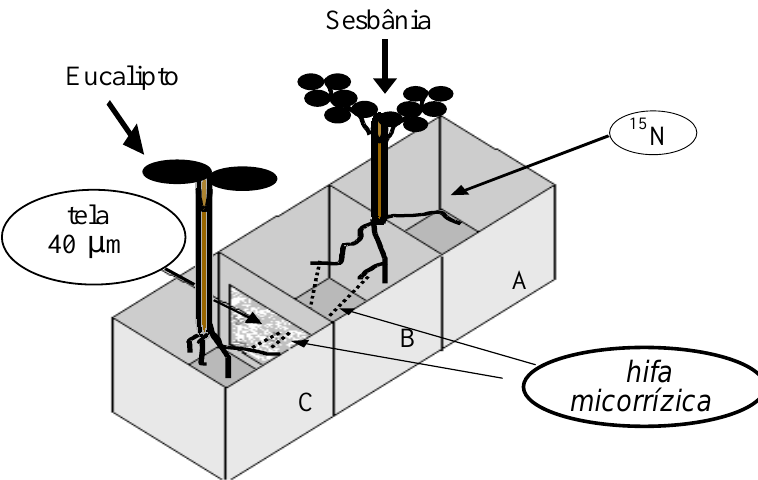
Figura 1. Esquema dos vasos utilizados e posição das